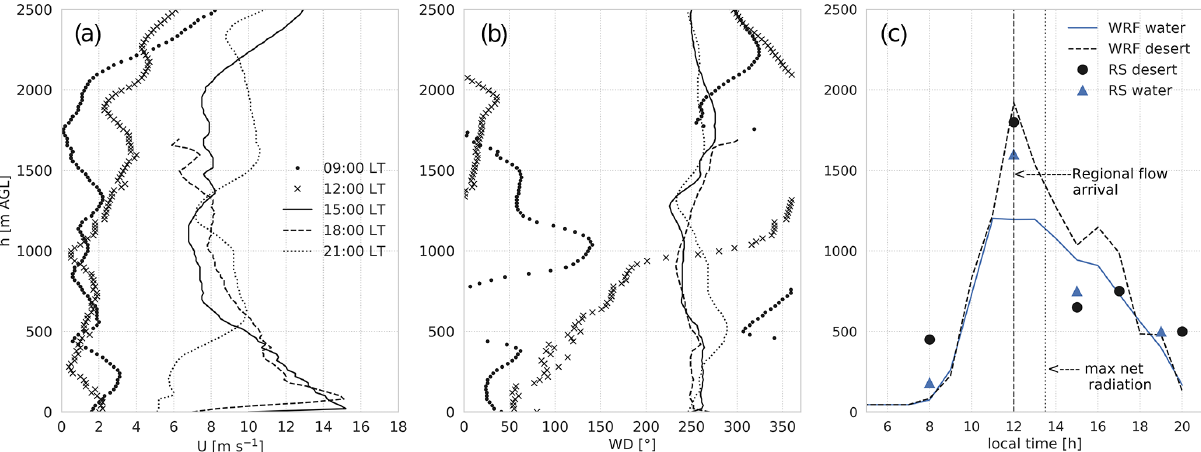
Figure 7. (a) Diurnal cycle of wind speed ( U ) and (b) wind direction (WD) vertical profiles and (c) boundary layer height ( h ) over the desert (22 November; 20.35 ◦ S, 69.90 ◦ W; 3931ma . s . l . ) and water (21 November; 20.27 ◦ S, 68.88 ◦ W; 3790ma . s . l . ) surfaces determined by radiosounding (RS) and WRF